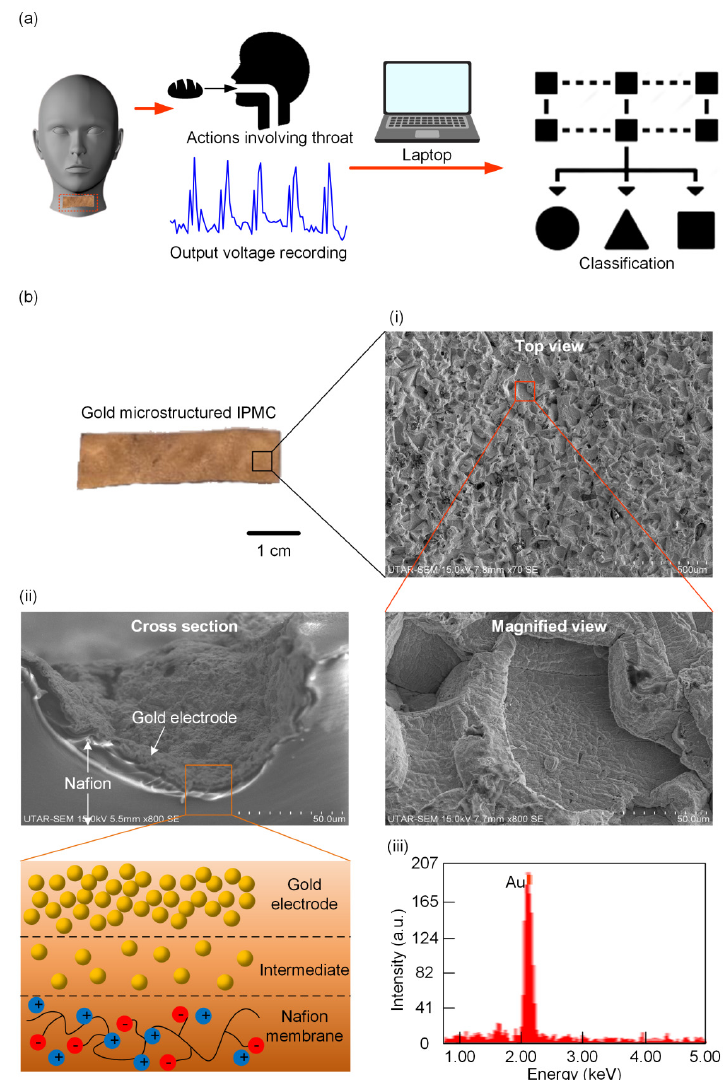
Figure 1. ( a ) A schematic drawing shows how the pattern recognition of the system is performed based on the input from a self-powered sensor that is attached to the throat. ( b ) Photograph of the gold-coated IPMC sensor. ( i ) SEM images examine the sponge-like surface morphology. ( ii ) SEM image and schematic illustration of the cross-sectional view of the IPMC sensor. ( iii ) EDX scanning confirms the formation of the metallic gold